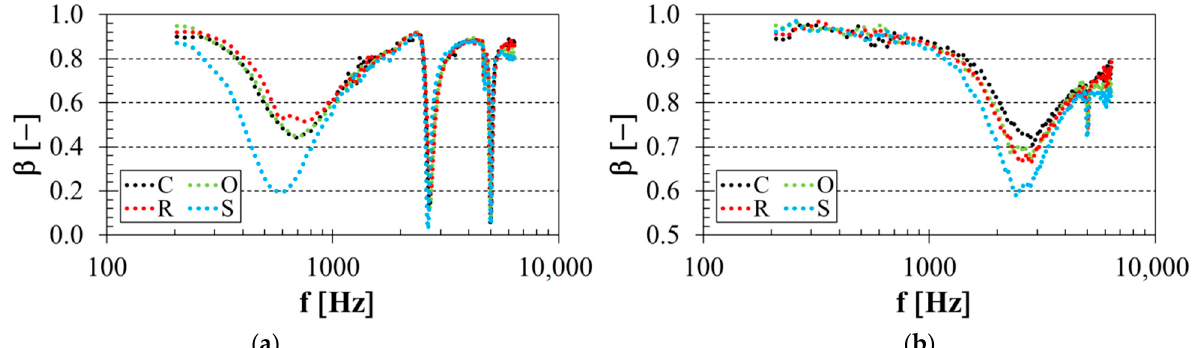
Figure 4. Influence of 3D-printed PLA structure type on the frequency dependencies of the sound reflection coefficient; ( a ) porosity P = 30%, specimen thickness t = 10 mm, air gap size a = 70 mm, ( b ) porosity P = 56%, specimen thickness t = 10 mm, air gap size a = 15 mm.